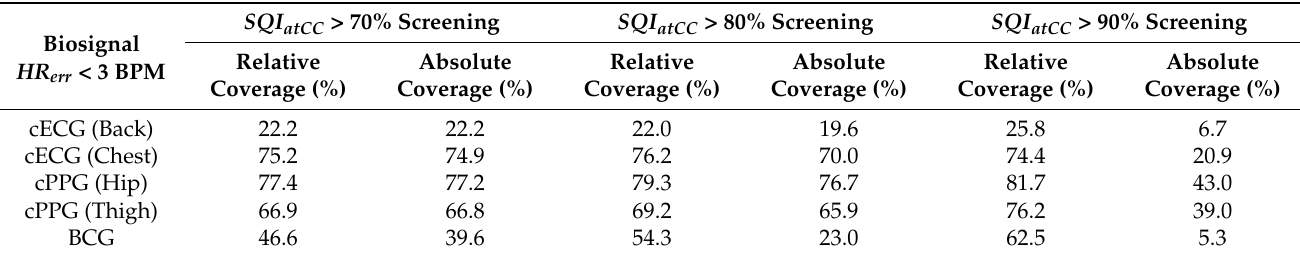
Table 4. Relative and absolute coverage (%) of HR err < 3BPM depending on the SQI conditions during the virtual driving